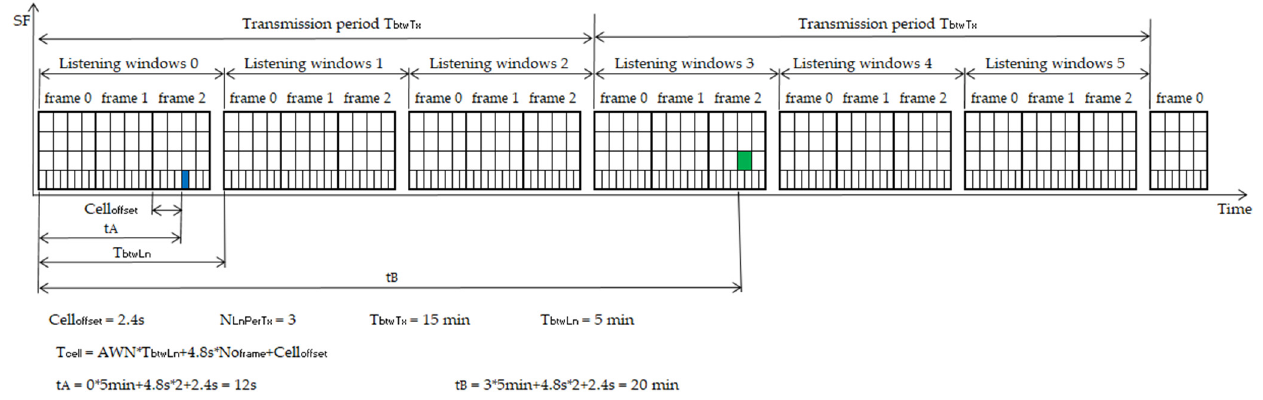
Figure 8. T cell calculated for cell A and B being tA and tB.